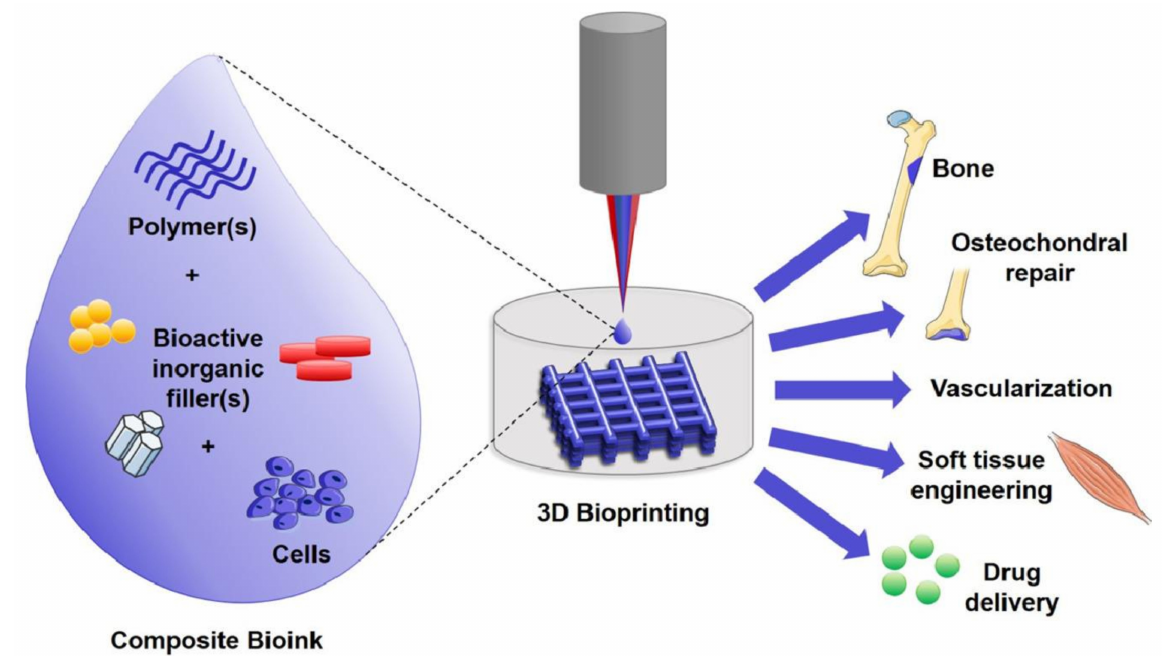
Figure 5. Multi-material bioinks used to bioprint 3D constructs for various biological applications [131].CC BY-NC-ND